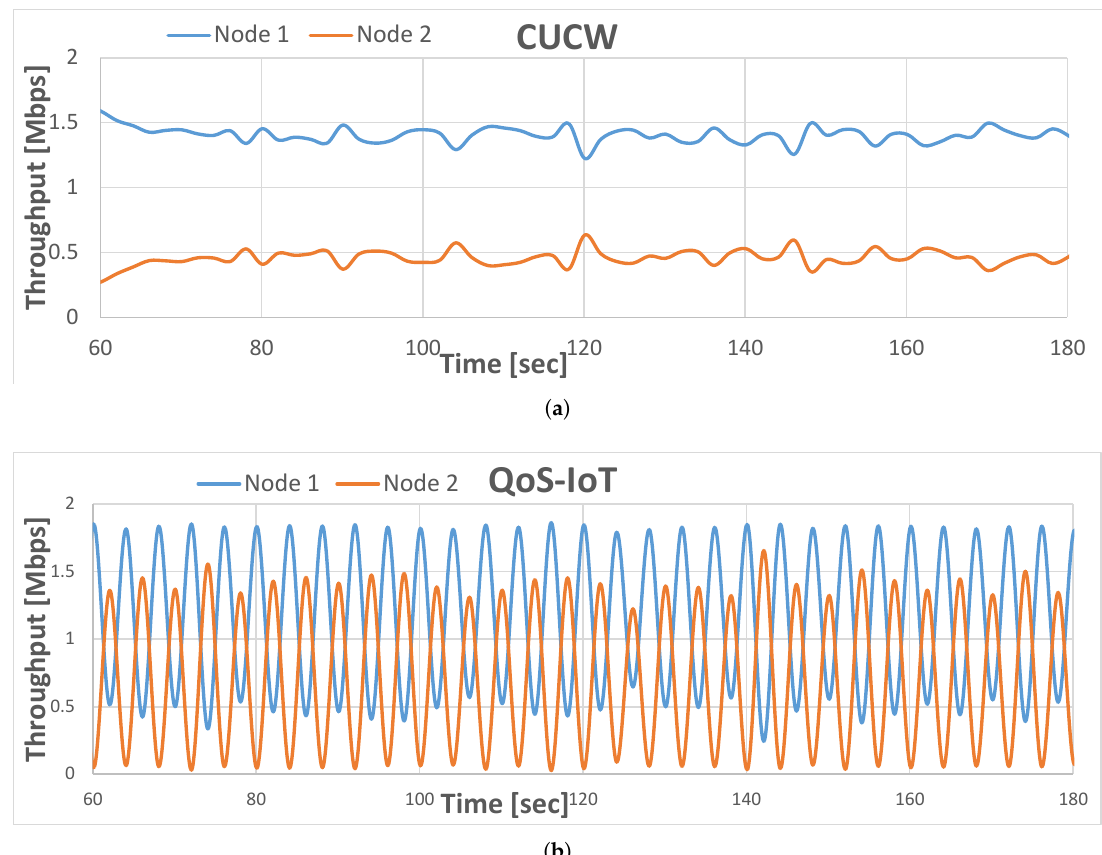
Figure 2. Simulation Results of CUCW [7] ( a ) and QoS-IoT ( b